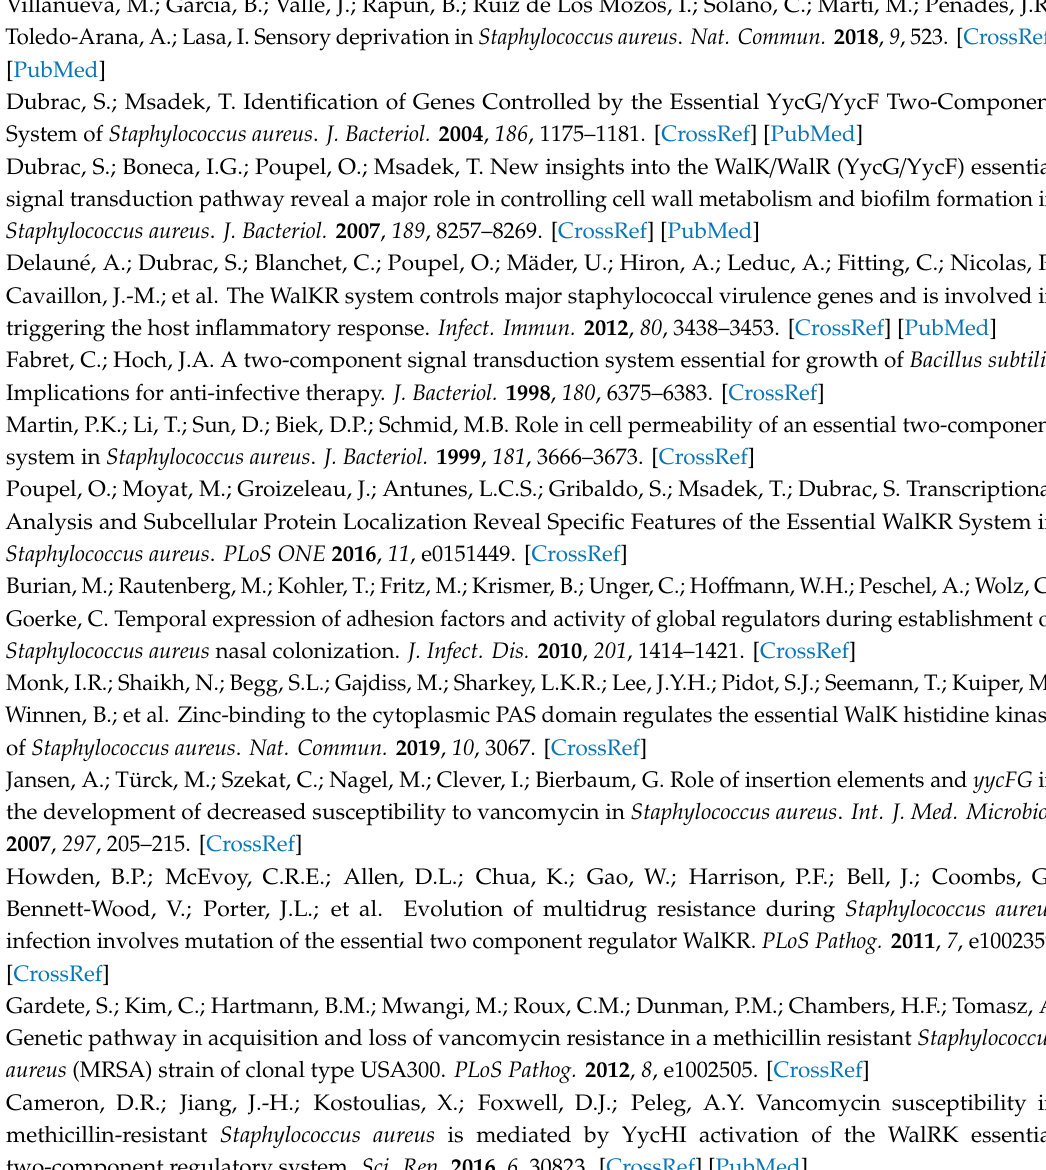
Figure S1: Bright field microscopy of S. aureus RN4220 pEPSA5-AS-yycHI with and without xylose after 30 h of incubation. Figure S2: E ff ect of lysed peptidoglycan fragments, d -alanine and WTA on the phosphorylation of WalRK in